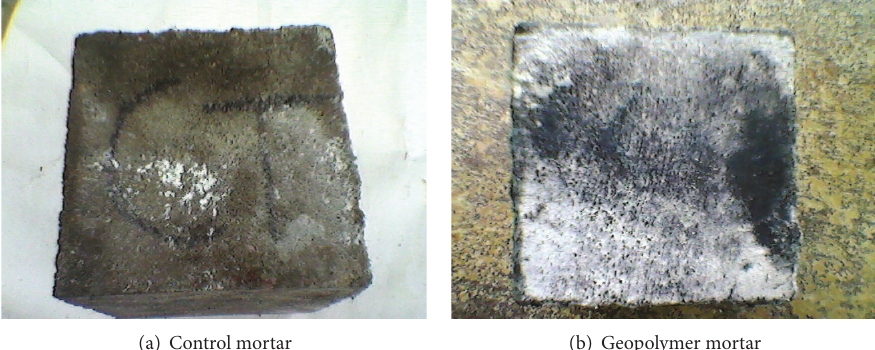
Figure 13: Photograph of specimen immersed in 5% N 2 SO 4 .